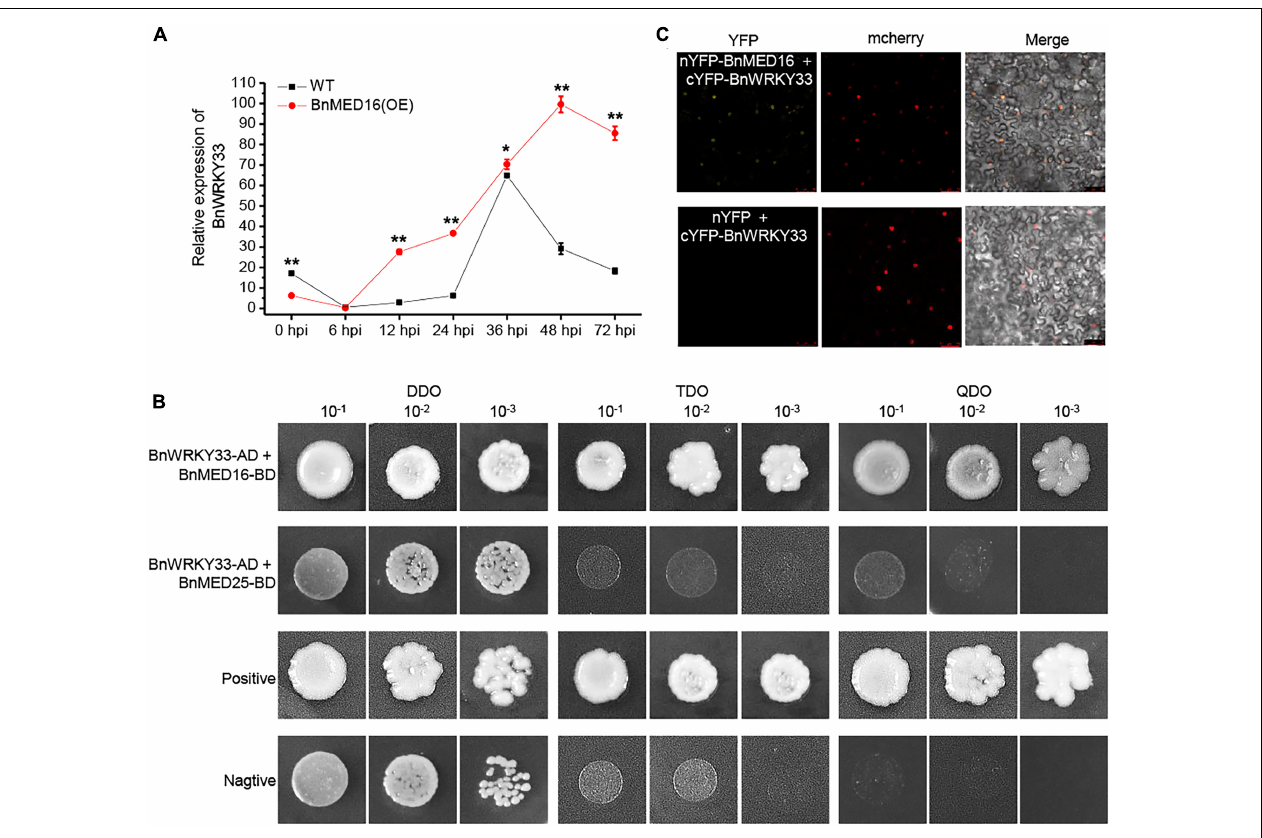
FIGURE 6 | Physical association between BnMED16 and BnWRKY33. (A) Expression pattern of BnWRKY33 ( BnaC04g06800D ) in BnMED16(OE) and WT seedling leaves at different time points after inoculation with S. sclerotiorum . BnActin7 was used as the internal control; Data are means ± SD of three biological replicates and the asterisks denote statistical significance at P < 0.01 (**) or P < 0.05 (*) between the WT and BnMED16(OE) lines at each time point by Student’s t -tests. (B) Yeast two-hybrid assays showing the interaction between BnWRKY33 and BnMED16. Transformed yeast cells were grown on SD media, and the colonies on TDO and QDO media indicate positive interactions. The positive control was pGADT7-RecT + pGBKT7-53 and the negative control was pGADT7-RecT + pGBKT7-lam. DDO, SD-Trp-Leu media; TDO, SD-Trp-Leu-His; QDO, SD-Trp-Leu-His-Ade; BnWRKY33-AD, pGADT7-BnWRKY33; BnMED16-BD and BnMED25-BD, pGBKT7-BnMED16 and pGBKT7-BnMED25. (C) BiFC assay showing that the interaction between nYFP-BnMED16 and cYFP-BnWRKY33 formed a functional YFP in the nucleus. mCherrey served as a nucleus marker. Merge = merging of YFP and mCherrey. The interactions between nYFP and cYFP-BnWRKY33 were used as negative controls for the BiFC assay. The other two negative controls were shown in Figure 5C as they did at the same time. Bars, 50 µ m. All the experiments were repeated at least three times with similar